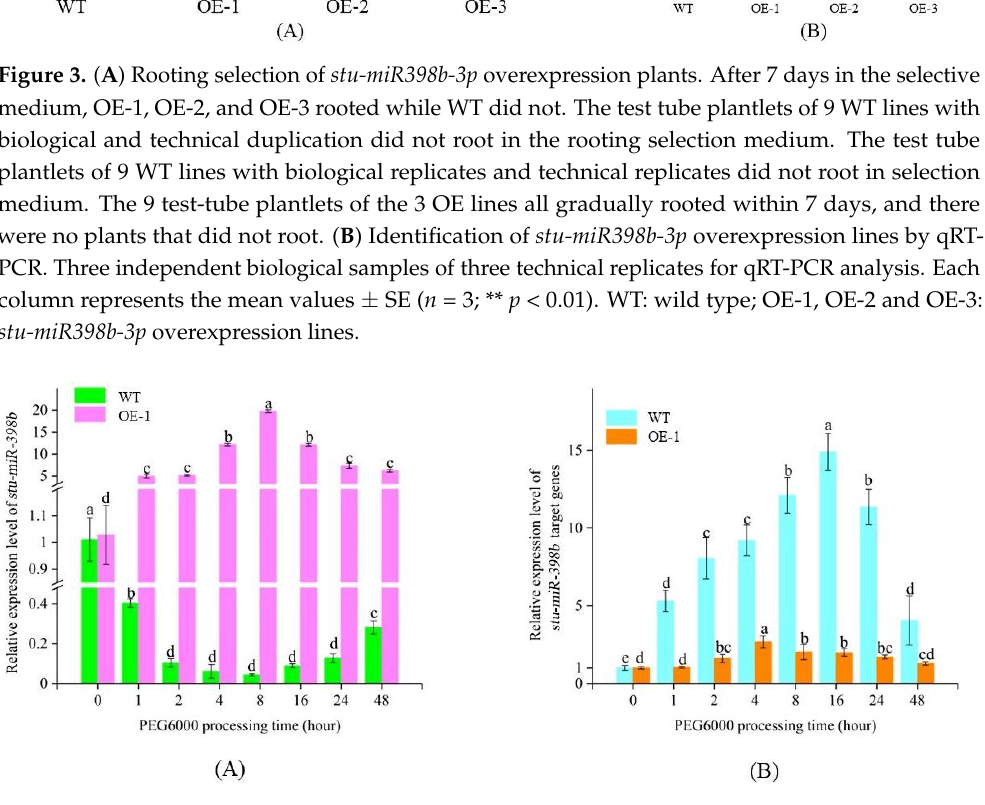
Figure 3. ( A ) Rooting selection of stu-miR398b-3p overexpression plants. After 7 days in the selective medium, OE-1, OE-2, and OE-3 rooted while WT did not. The test tube plantlets of 9 WT lines with biological and technical duplication did not root in the rooting selection medium. The test tube plantlets of 9 WT lines with biological replicates and technical replicates did not root in selection medium. The 9 test-tube plantlets of the 3 OE lines all gradually rooted within 7 days, and there were no plants that did not root. ( B ) Identification of stu-miR398b-3p overexpression lines by qRT- PCR. Three independent biological samples of three technical replicates for qRT-PCR analysis. Each column represents the mean values ± SE ( n = 3; ** p < 0.01). WT: wild type; OE-1, OE-2 and OE-3: stu-miR398b-3p overexpression lines.